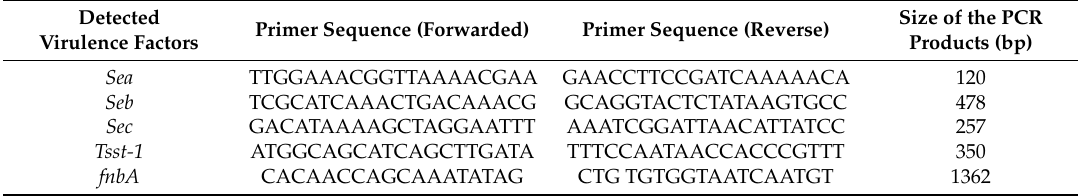
Table 5. Virulence genes and the primers used for the detection of S. aureus LC554891